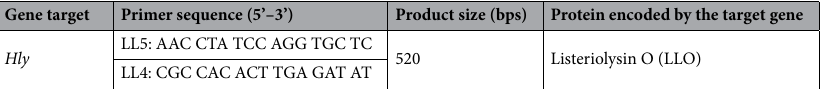
Table 1. Nucleotide sequences of primer sets used in this